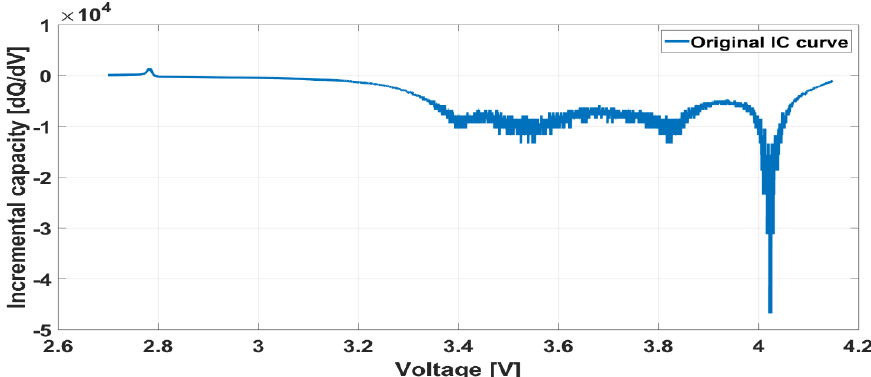
Figure 7. Experimental apparatus for the aging cycle test of the NCA cell.